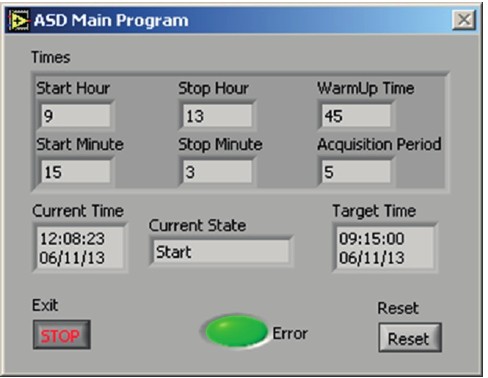
Figure 4. The user-friendly interface of the LabVIEW acquisition software. The acquisition start hour, stop hour and warm up time can be easily setup and the status is